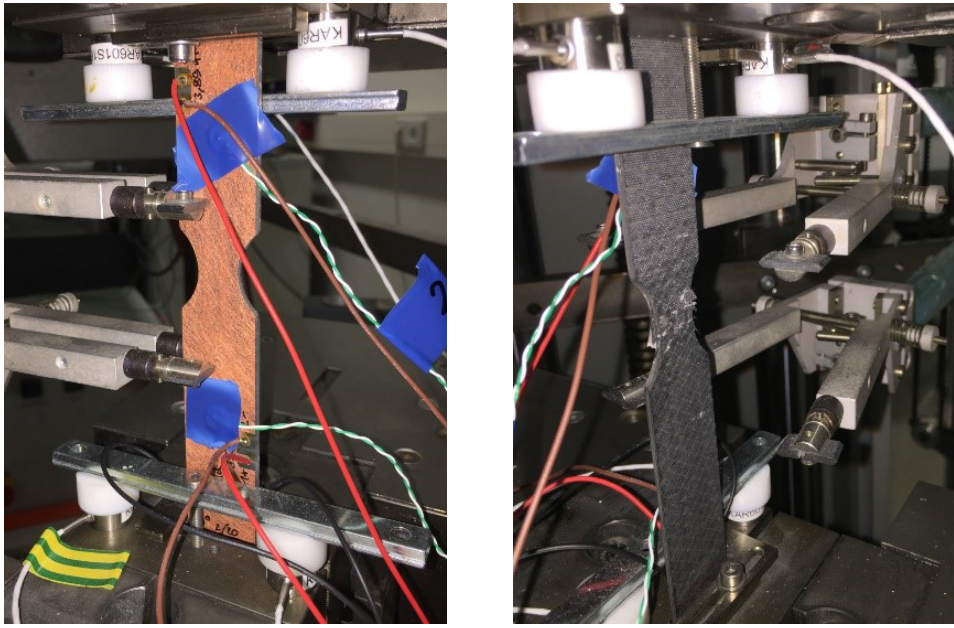
Figure 1. Clamped test specimen with embedded transducers for guided wave measurements and attached sensors for acoustic emission measurements. Left : Test specimen before starting the measurement. Right : Test specimen after successful